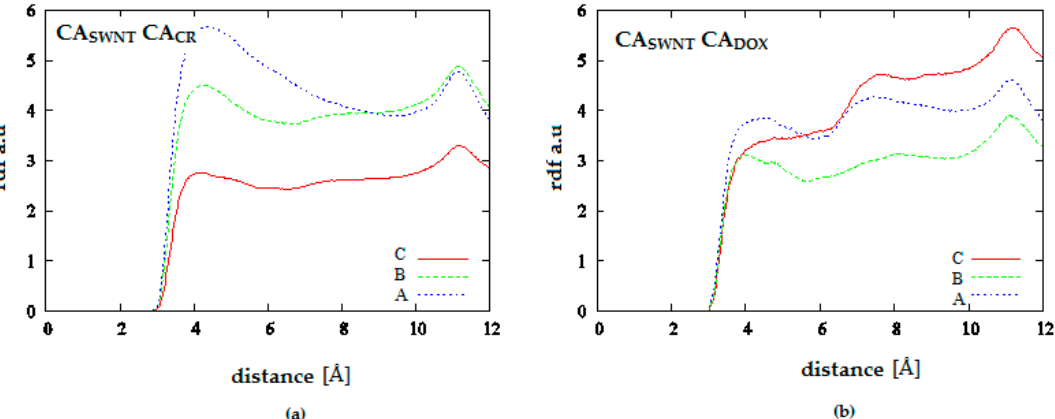
Figure 12. Radial distribution functions for the system SWNT (10.0) complexed with 20 molecules of CR and 10 molecules of DOX; ( a ) SWNT-CR interaction; ( b ) SWNT-DOX interaction; (A—neutral pH, B—medium pH, C—acidic pH).